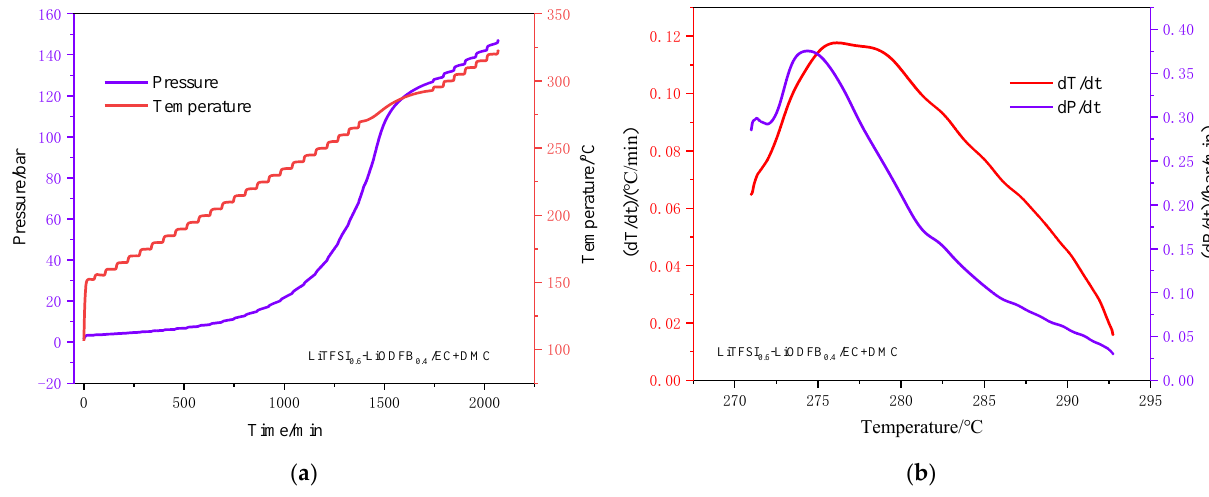
Figure 4. ARC curves of LiTFSI 0.6 -LiODFB 0.4 /EC + DMC (2:3, v/v ). ( a ) Pressure and temperature versus time curves; ( b )Self-temperature rise rate and self-pressure rise rate versus temperature curves. Table 3. Characteristic parameters of electrolyte samples in the ARC experiment.